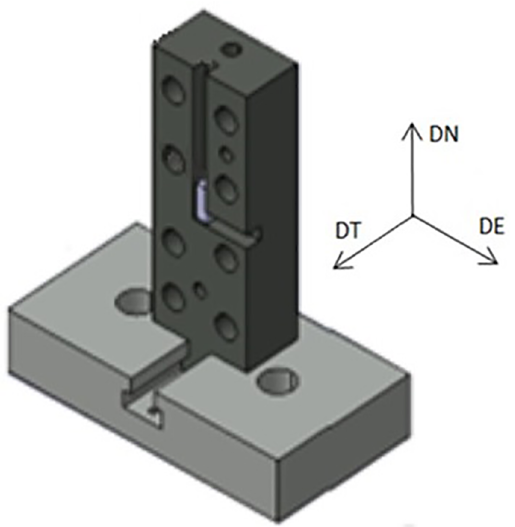
Figure 1. Schematic drawing of the matrix within sample positioned in the vertical channel 7 . temperatures were measured with a K-type thermocouple placed at the end of workpieces and the temperature control was performed by the on/off method on a circuit breaker connected to two 650W tubular resistors placed in the specific openings for them in the ECAP die. The tests were interrupted when the punch reached 35 mm from the stroke, 5 mm to the end of the inferior